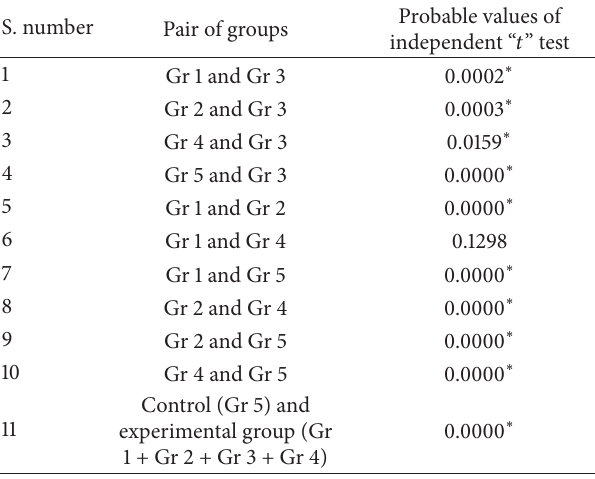
Table 2: Pair-wise comparison between different groups for com- paring the significant difference in